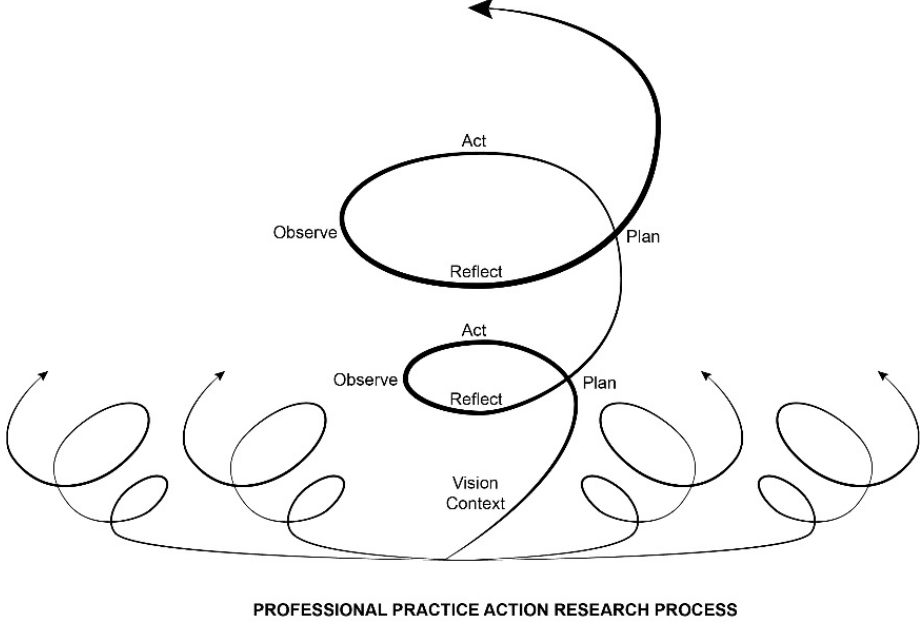
Figure 2: Visionary action research model executed by a scholarly community of practice (Fringe